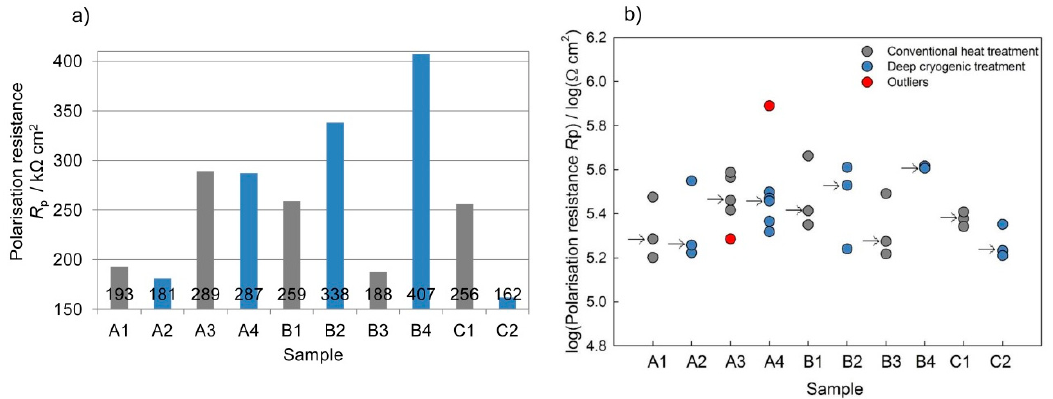
Figure 10. ( a ) Comparison of polarization resistance values; ( b ) scatter diagram of measurements on steel grades A, B and C in a Na-tetraborate buffer, pH 10.